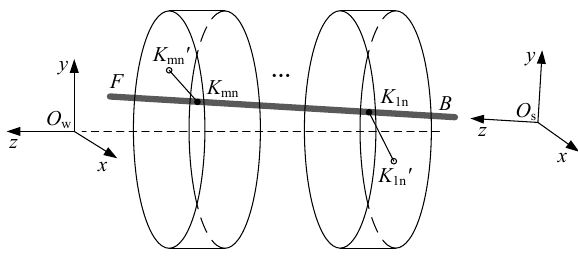
Figure 3. The Global Coordinate System and the Measuring Rod Coordinate System.